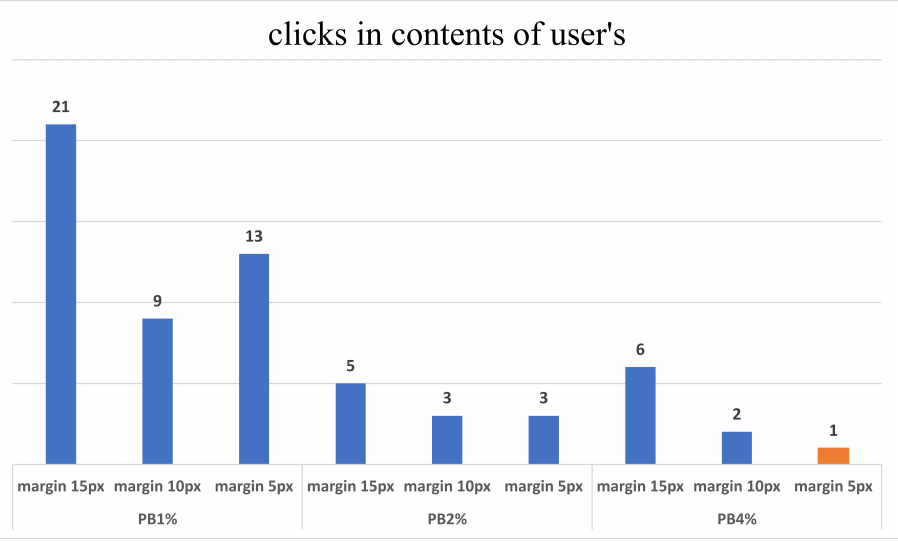
Figure 5. Amount of wrong clicks in synthetic